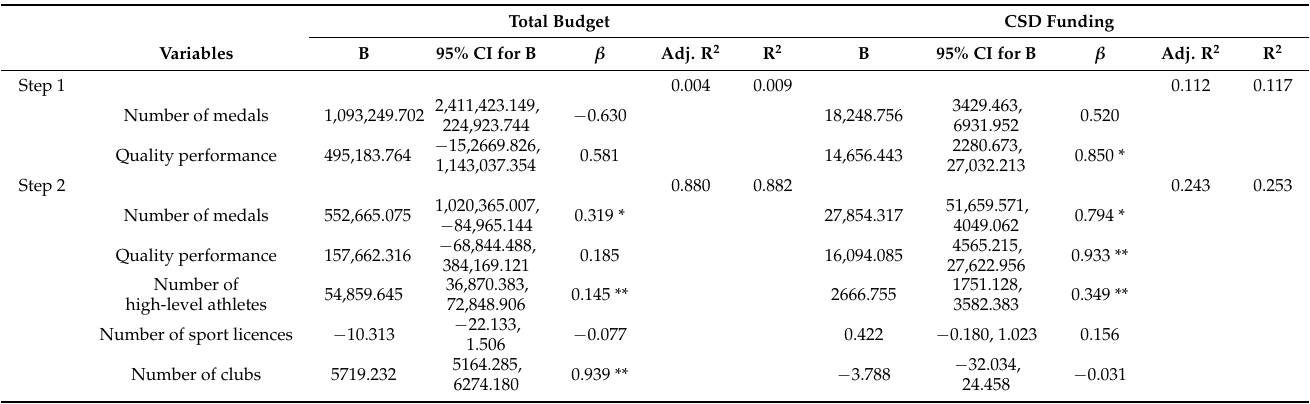
Table 5. Multiple regression model of predictors associated with the financing of non-Olympic sport